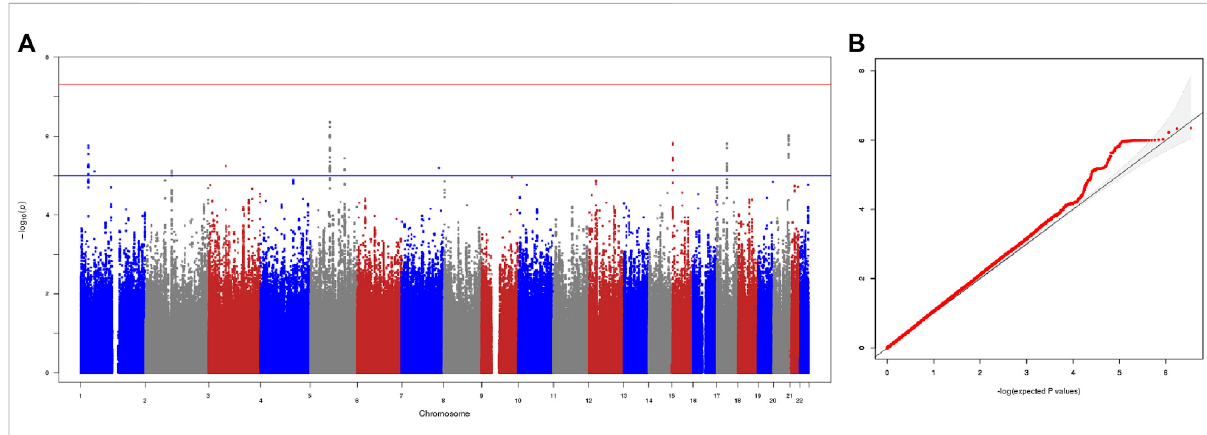
FIGURE 1 Results of meta-GWAS of the two cohorts. (A) The − log 10 genome-wide p values using a fi xed-effects inverse-variance meta-analysis calculatedonthebasisofdatafromoverlapped3478293SNPsinthe148goodrespondersand29poorresponders.Thebluehorizontallinepresents aliberalthresholdof10 − 5 for suggestivesigni fi cance.Theredhorizontallineindicatesgenome-widesigni fi cance ( p < 5×10 − 8 ). (B) Quantile-quantile plots of the observed p values versus the expected values form p value of association. λ gc =